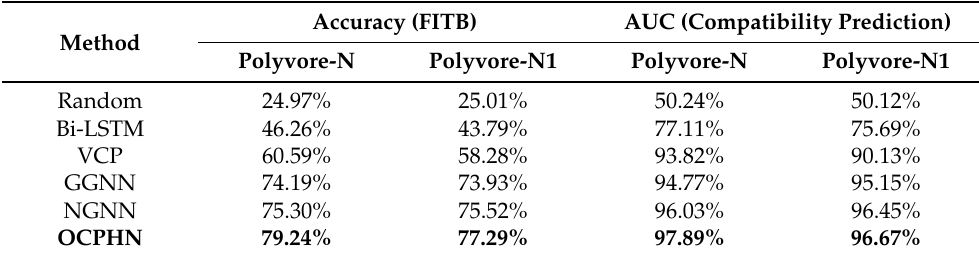
Table 2. The performance of models evaluated by fill-in-the-blank accuracy and compatibility prediction expressed as the